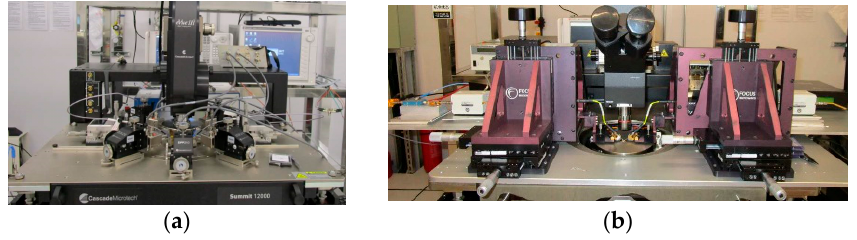
Figure 2. The on-wafer measurement system. ( a ) The measurement desk for DCIV and S parameter; ( b ) The on-wafer load-pull system.